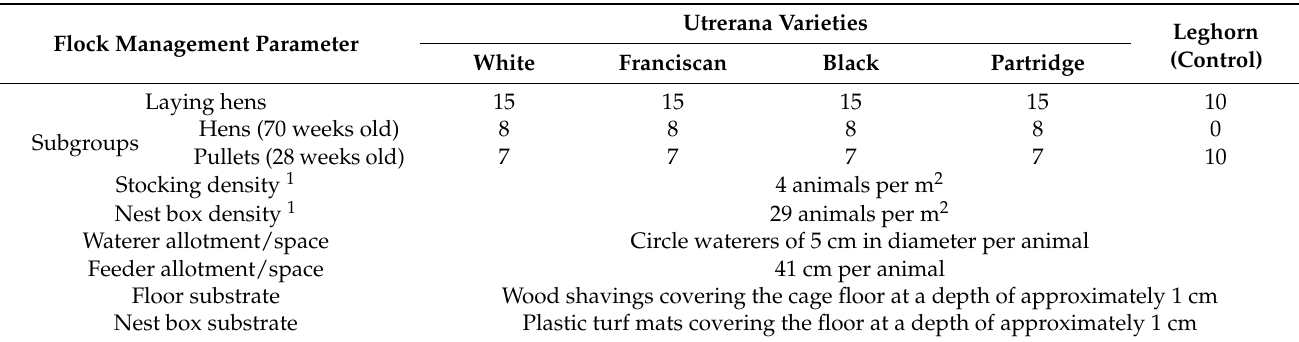
Table 1. Flock management information. All cages were chosen according to Council Directive 1999/74/EC of 19 July 1999, laying down minimum standards for the protection of laying hens.